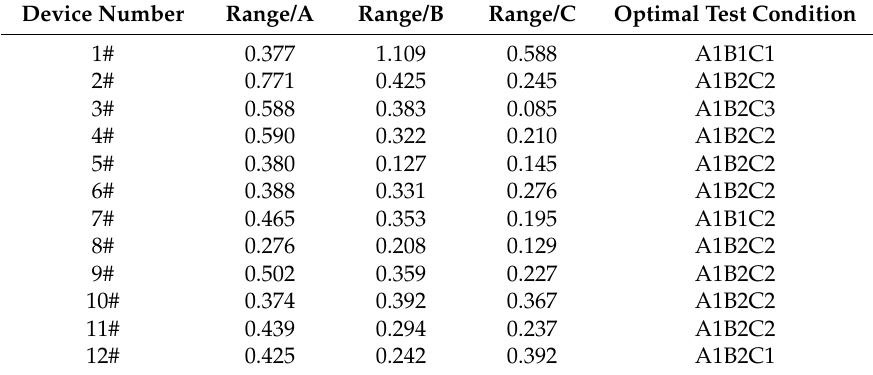
Table 5. Range of the three factors and optimal test condition in different